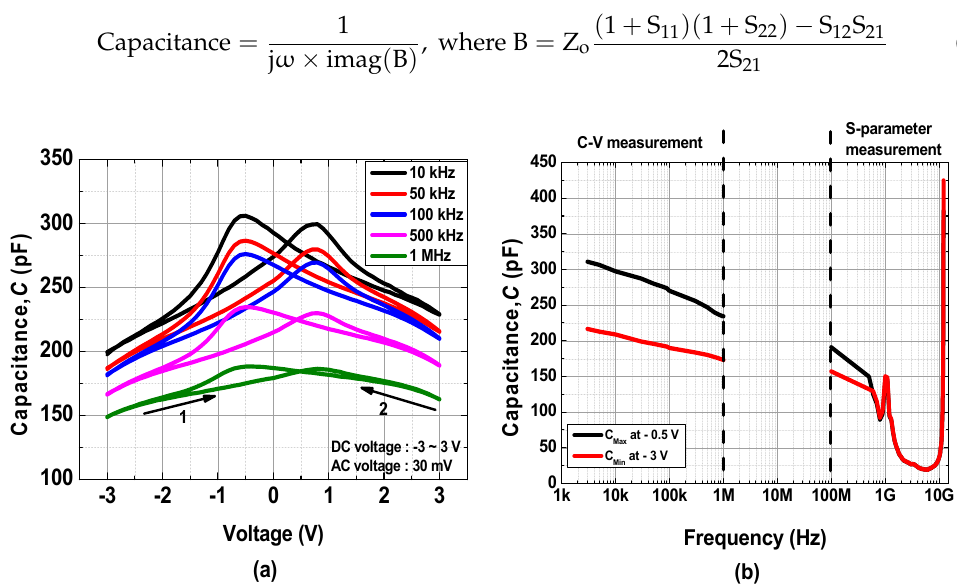
Figure 6. ( a ) Capacitance characteristics measured from 10 kHz to 1 MHz and ( b ) capacitance tunability characteristics versus frequency.